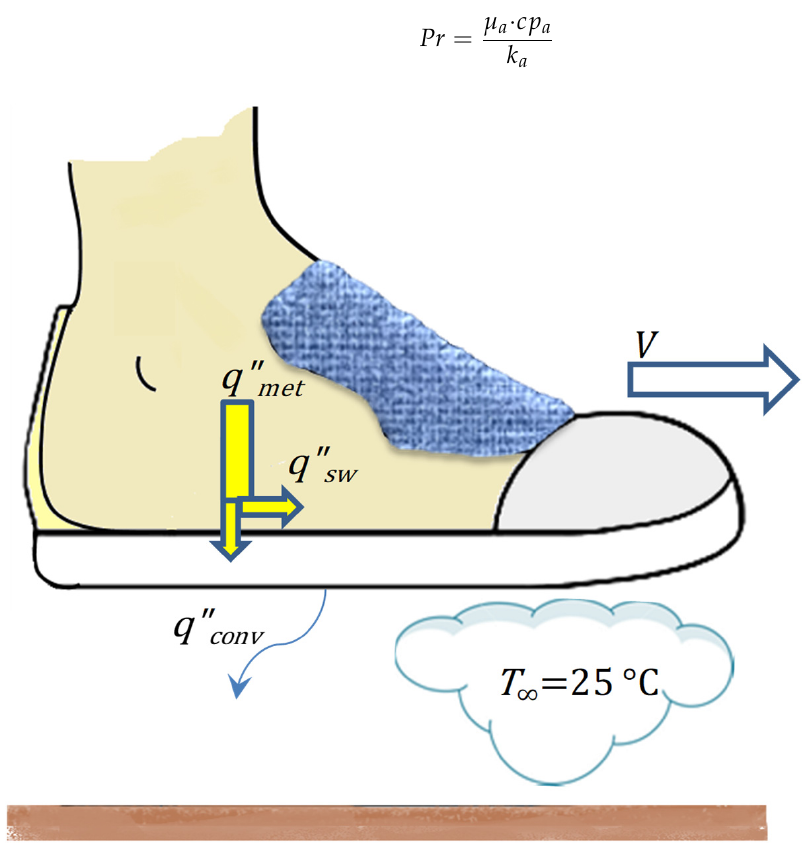
Figure 1. Different forms of heat transfer to/from shoe sole.